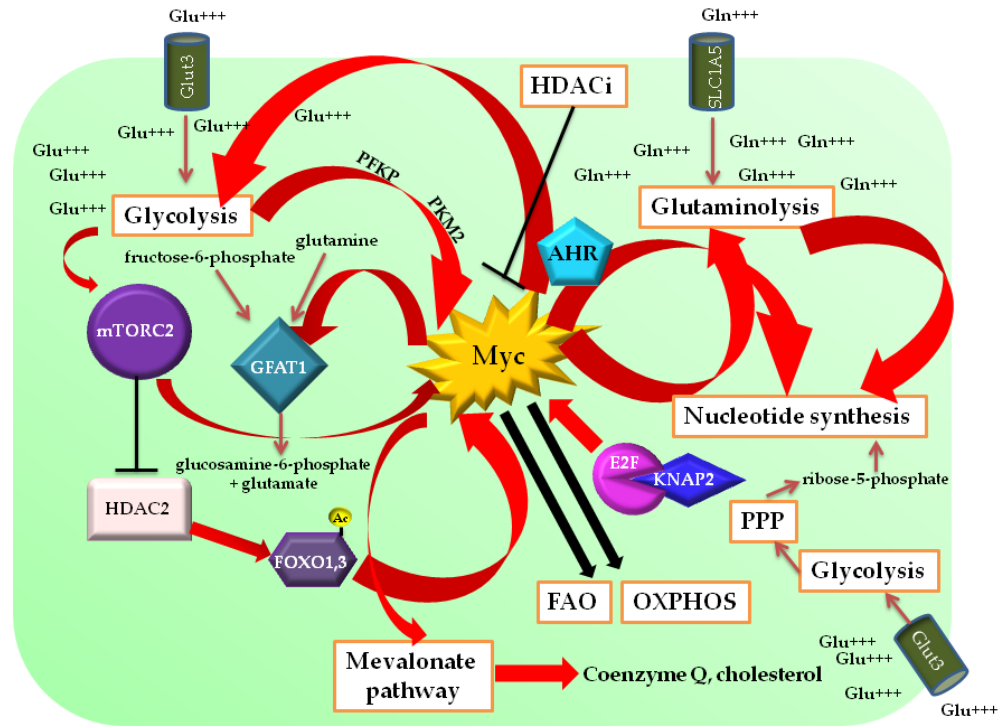
Figure 3. Myc at the intersection between metabolism and gene expression in glioblastoma. The image depicts the major metabolic pathways that regulate and are regulated by Myc in GBM. Basically, Myc controls all the metabolic pathways in GBM, whereas glycolysis remains the main controller of Myc activity in this type of brain tumor. Glu—glucose;